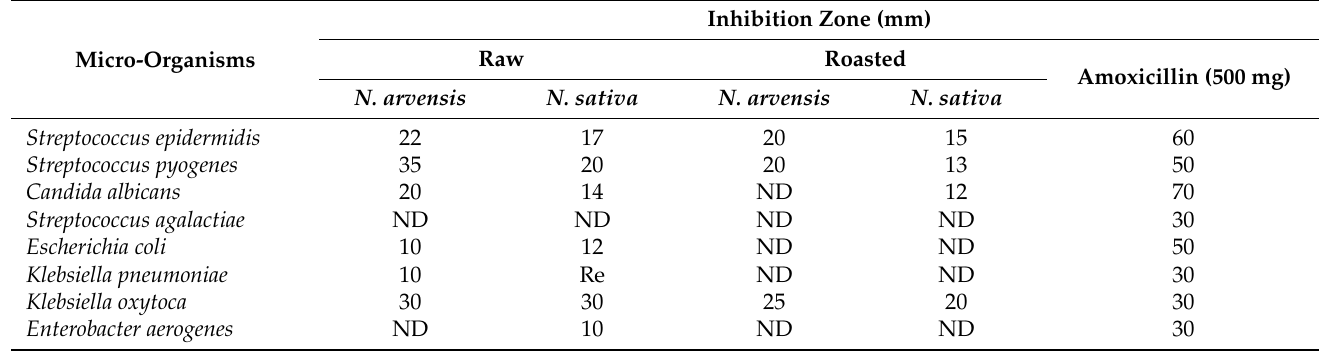
Table 1. Antimicrobial activity of raw and roasted N. arvensis and N sativa